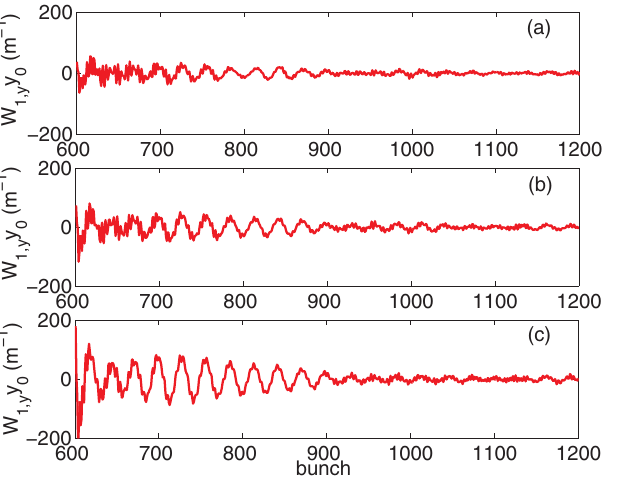
(cid:1) 20 (a) and 30 G (b) for a FIG. 11. (Color) Wake force for B z displacement of the 600th bunch of 5 mm. Primary electrons are produced uniformly on the chamber surface and secondary ones are not considered. appears in Fig. 12(a). Note that the revolution frequency is (cid:1) 20 and 30 G, modes with 20 (cid:5) 43 (cid:6) 0.1 MHz. For B z 1280 (cid:9) 1260 and 12 (cid:5) 43 (cid:6) 1280 (cid:9) 1250 appears in Figs. 12(b) and 12(c), respectively. The mode spectrum has two frequency components near the cyclotron fre- quency; one may be ! and the other ! . However the (cid:6) c wake force does not possess linearity for the fast frequency component. We have to wait for the results of tracking simulation to determine whether the unstable modes with ! and ! are observed. (cid:6) c